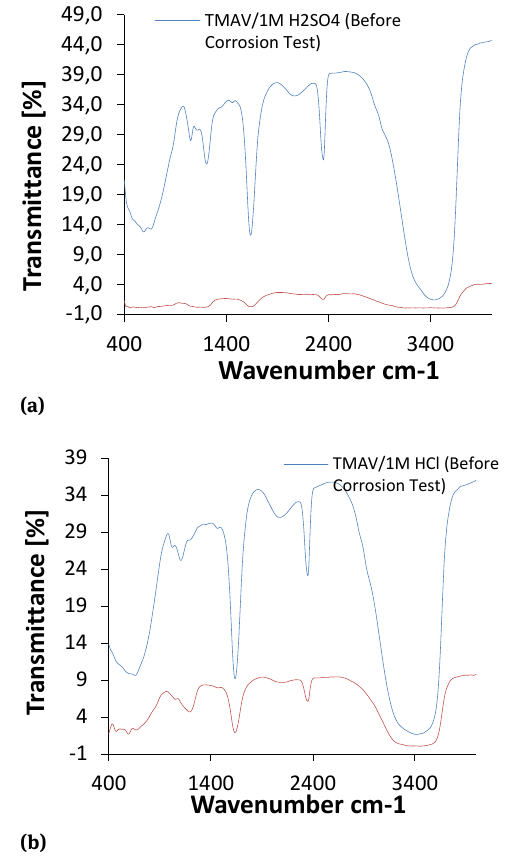
Figure 11: IR spectra of TMAV/acid solution before and after corro- sion test from (a) H 2 SO 4 solution and (b) HCl